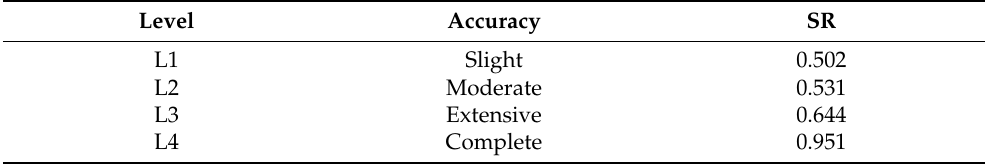
Table 2. Case Study (Hp: linear repair